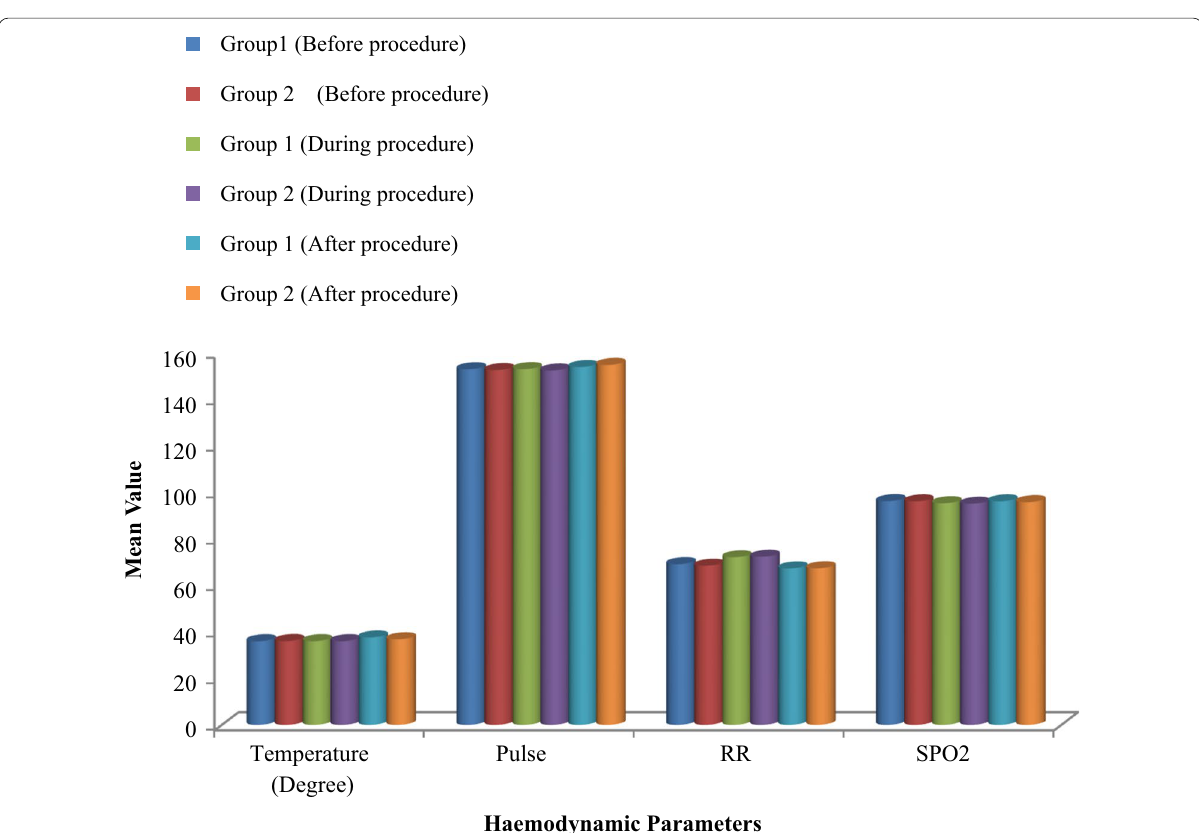
Fig. 1 Comparison of hemodynamic parameters before, during and after the procedure between two groups